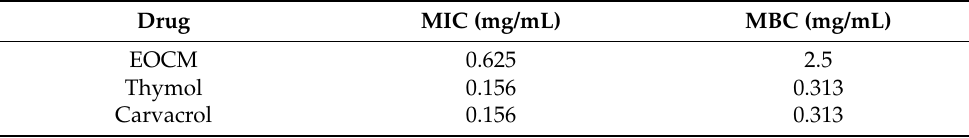
Figure 1. Structural formula of chemical components with content greater than 0.5% in EOCM. Table 2. MIC and MBC of EOCM to S. aureus